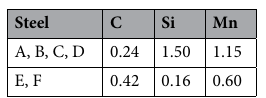
Table 2. Chemical composition of each steel (all units are in